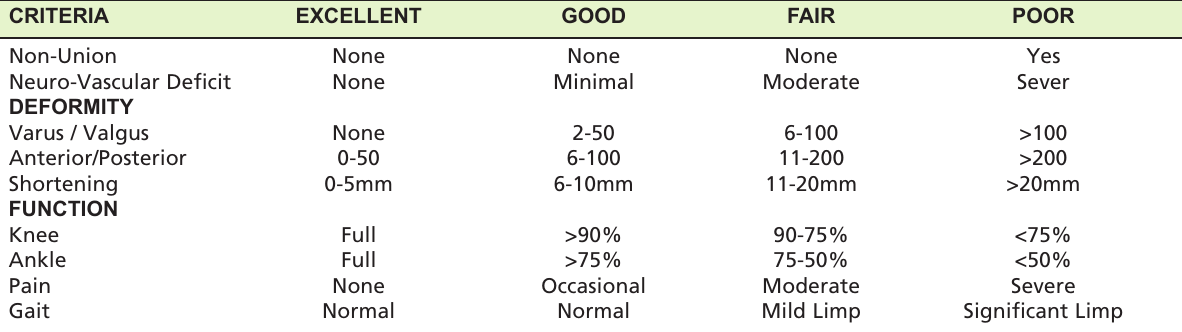
Johner and Wruhs criteria for clinico-radiological Table I: